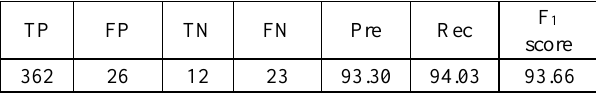
Table 1. Vehicle detection accuracy (TP: True Positives; FP: False Positives; TN: True Negatives; FN: False